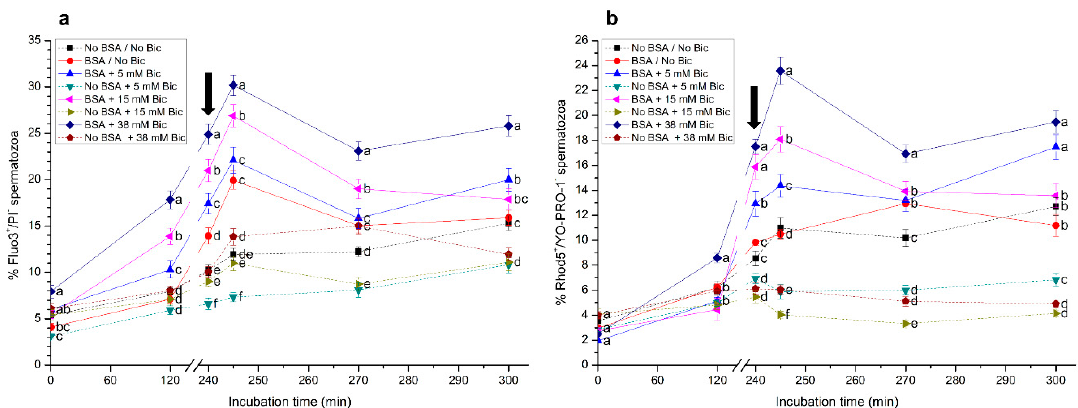
Figure 4. Percentages of viable sperm with high intracellular calcium levels evaluated through Fluo3 + /PI − ( a ) and Rhod5 + /YO-PRO-1 − ( b ) following incubation with different concentrations of bicarbonate (Bic; 0 mM, 5 mM, 15 mM, 38 mM) and BSA (0, 5 mg/mL) for 300 min. The black arrow indicates the time at which 10 µ g/mL of progesterone was added (i.e., 240 min) to induce acrosome exocytosis. Different superscripts (a–e) indicate significant differences ( p < 0.05) between treatments within the same time point. Data are shown as mean ± SEM for 12 independent experiments.